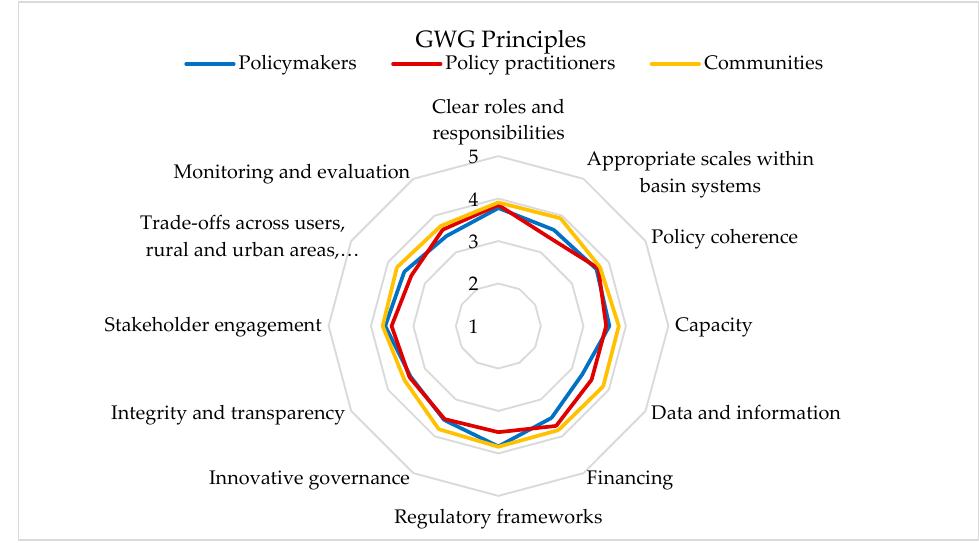
Figure 3. Key principles of the groundwater governance framework in different views.